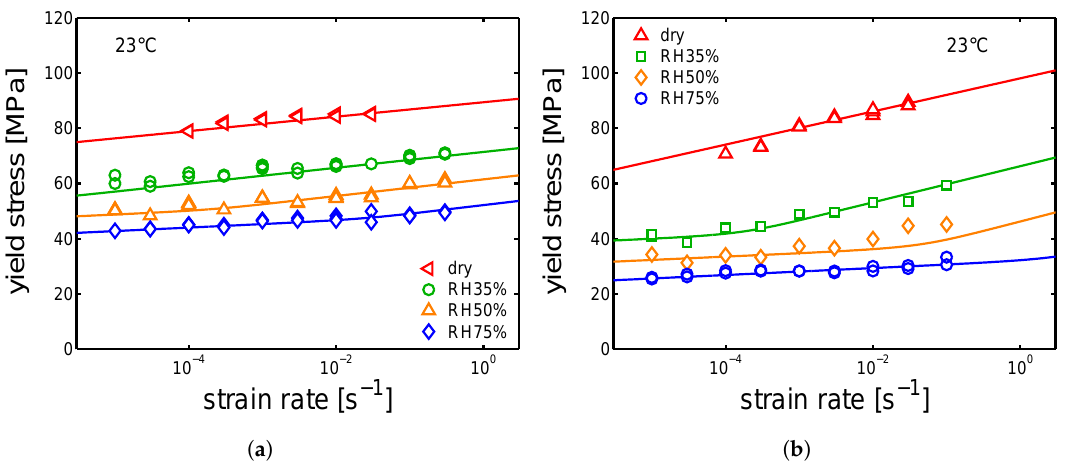
Figure 16. ( a ) yield stress as a function of strain rate for samples conditioned at different relative humidities, ( a ) α -I and ( b ) γ -I Testing temperature set at 23 °C.